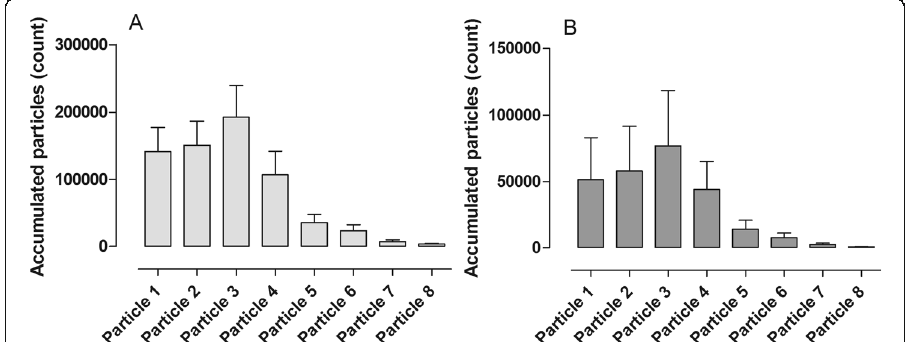
Fig. 4 Distribution of different particle sizes during different ventilation modes in ex vivo lung perfusion (EVLP). a Volume-controlled ventilation (VCV), and b pressure-controlled ventilation (PCV). Note the differences in the total amount of particle count in the two different ventilation settings; interestingly, the same particle size distribution was seen in the both settings